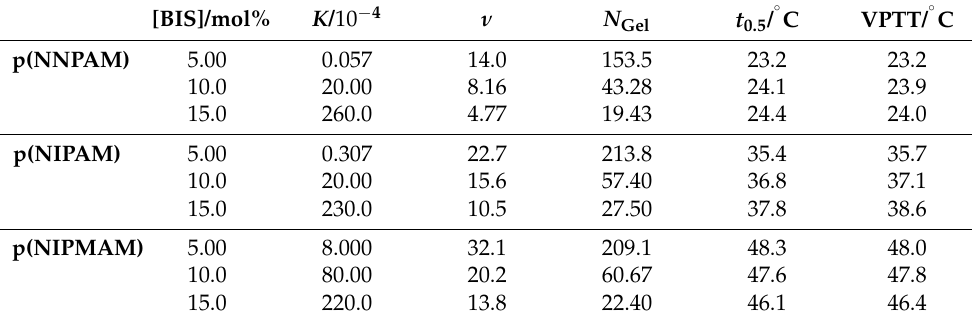
Figure 2. Hydrodynamic radius R H vs. temperature t at different concentrations of the cross- linker BIS in p(NNPAM) ( a – c ), p(NIPAM) ( d – f ), and p(NIPMAM) ( g – i ) particles. The fit of the hydrodynamic radii R H (solid curve) was calculated using the Flory–Rehner Equation (2) with the Hill-like Equation (6) for the interaction parameter χ . A nearly perfect fit to the experimental data was achieved for all measured BIS concentrations. Table 1. Parameters resulting from the fit of swelling curves with the Hill-like Equation (6) and the volume phase transition temperature (VPTT) determined from the inflection point of the R H ( t ) – swelling